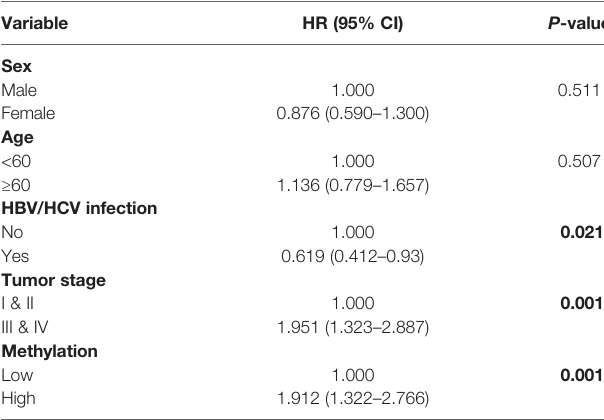
TABLE 2 | Multivariate Cox regression analysis of potential independent prognostic factors for HCC patients.